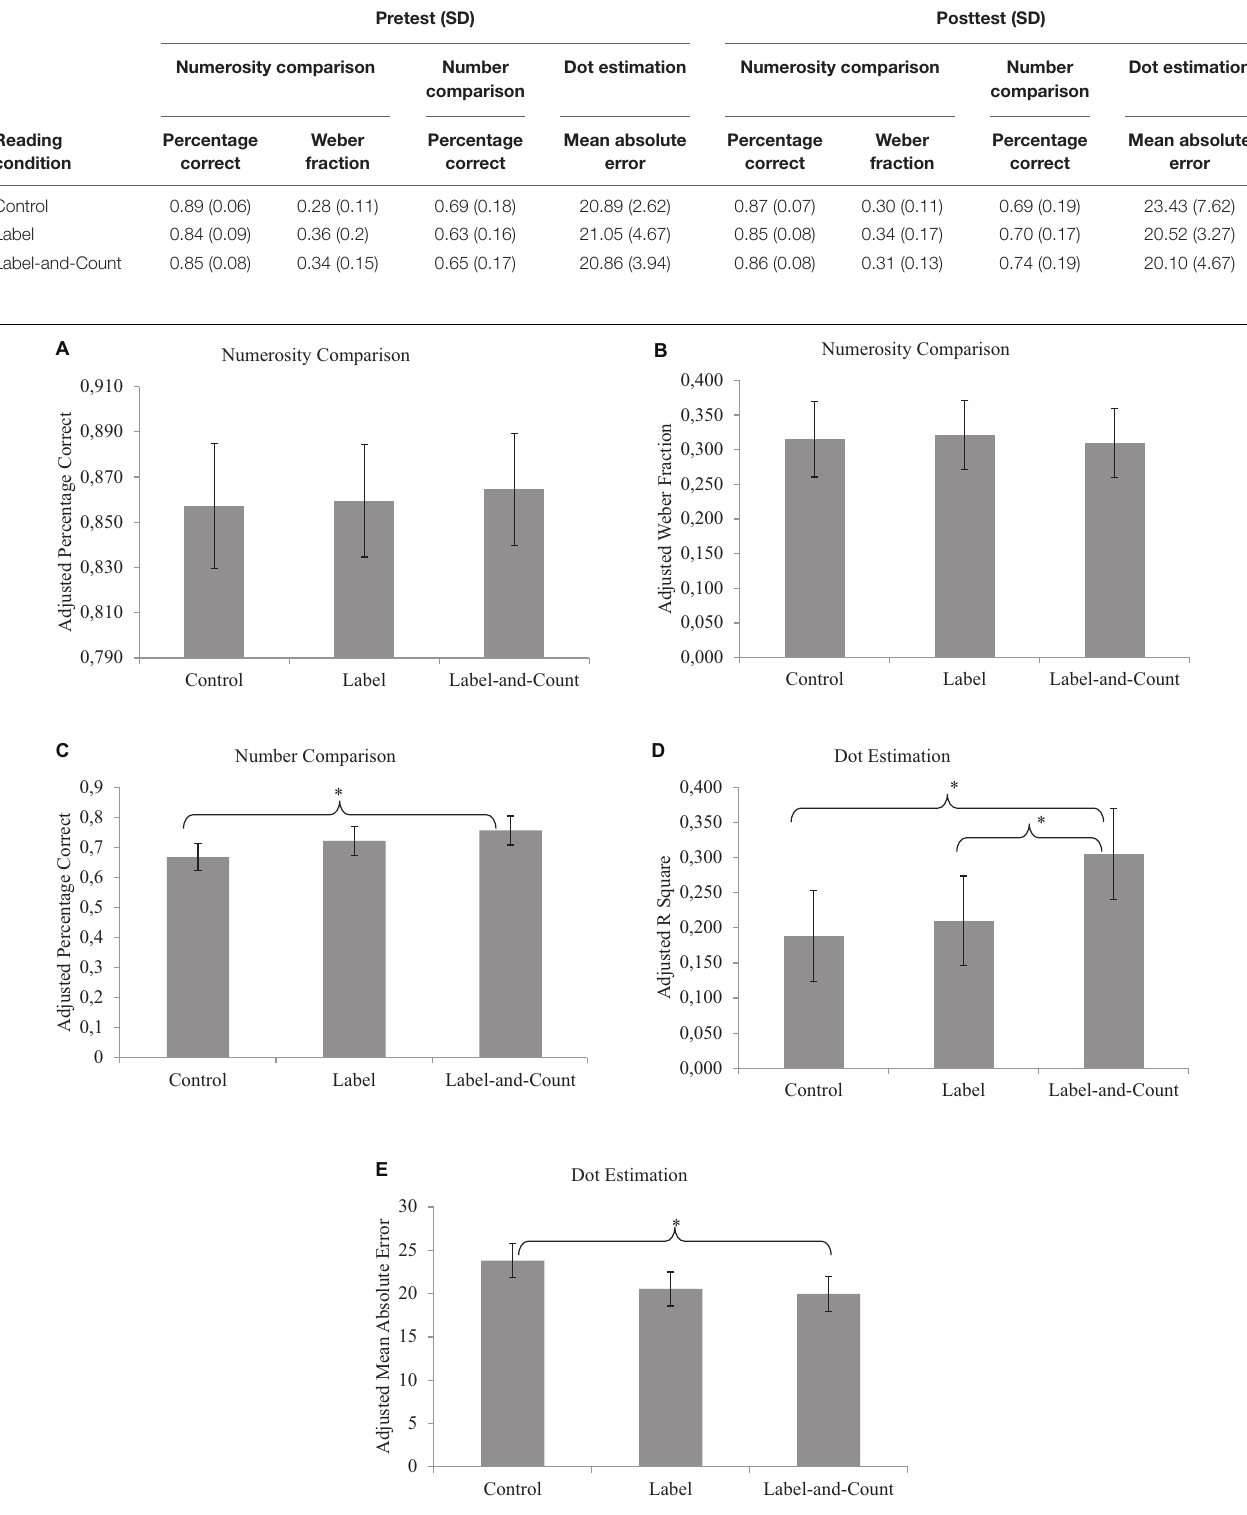
TABLE 2 | Mean Scores of children in different reading conditions.